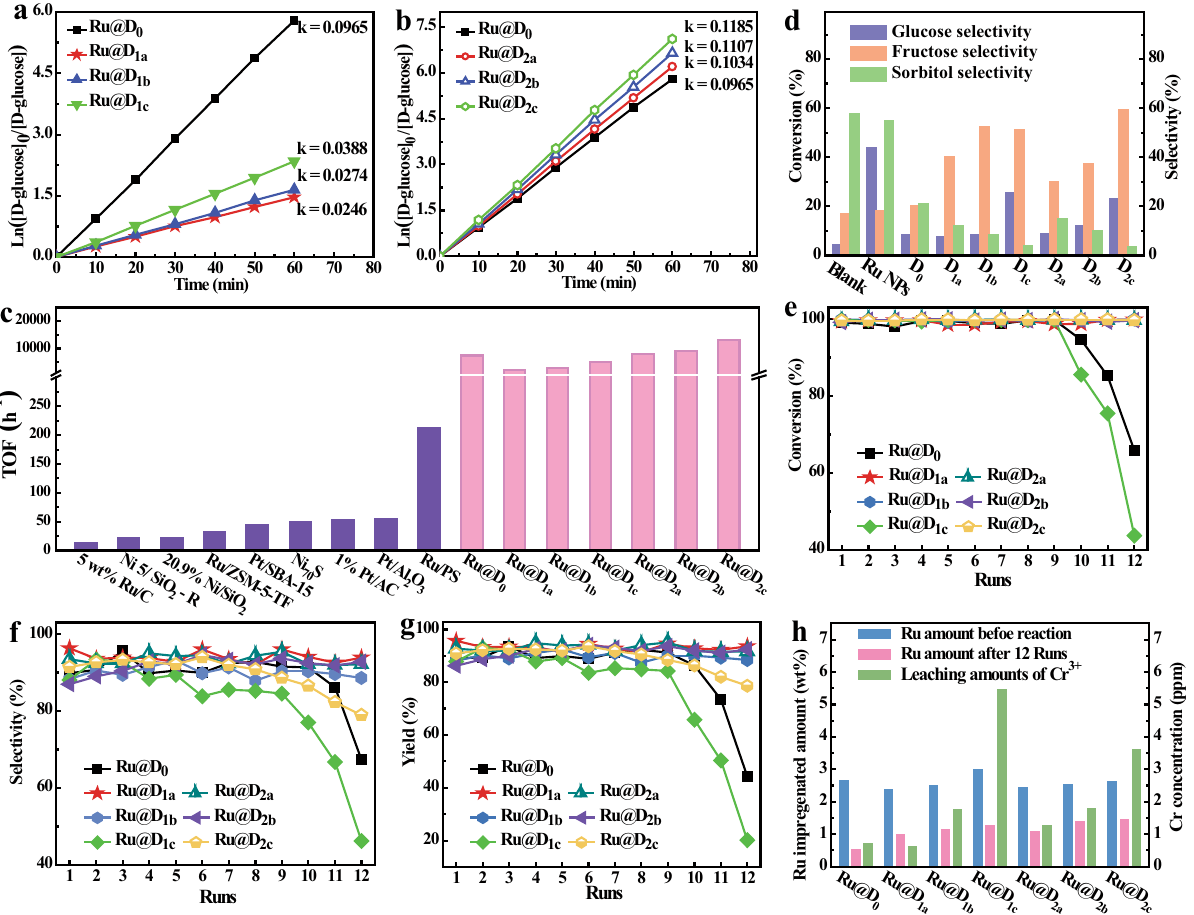
Fig. 4 Catalytic activity and recyclability of Ru@D0 and Ru@DEMOFs catalysts. a , b Kinetic studies of D-glucose selective hydrogenation reactions catalyzed by Ru@D 0 and Ru@D 1a-c ( a ), by Ru@D 0 and Ru@D 2a-c ( b ). c Comparison of TOF values between the Ru-impregnated MOFs catalysts in this work and various reported catalysts for the fi rst run reaction. d Comparison of D-glucose conversion and selectivity to fructose and sorbitol without catalyst and catalyzed by pristine and defect-engineered MIL-100-Cr MOFs. e – g Comparison of D-glucose conversion ( e ), selectivity to sorbitol ( f ), and sorbitol yields ( g ) for the reactions catalyzed by Ru@D 0 and Ru@D 1a-c and Ru@D 2a-c for 12 recycles. h The impregnated amount of Ru NPs in Ru@D 0 , Ru@D 1a-c , and Ru@D 2a-c before and after catalyzing for 12 runs and the leaching amount of Cr 3 + ions after catalyzing for the third run. Reaction conditions: glucose aqueous solution (25 wt%, 1.543 mol/L, 50 g), catalyst amount (1 g), H 2 (5.0 MPa), temperature (120 °C), stirring rate (600 rpm), and